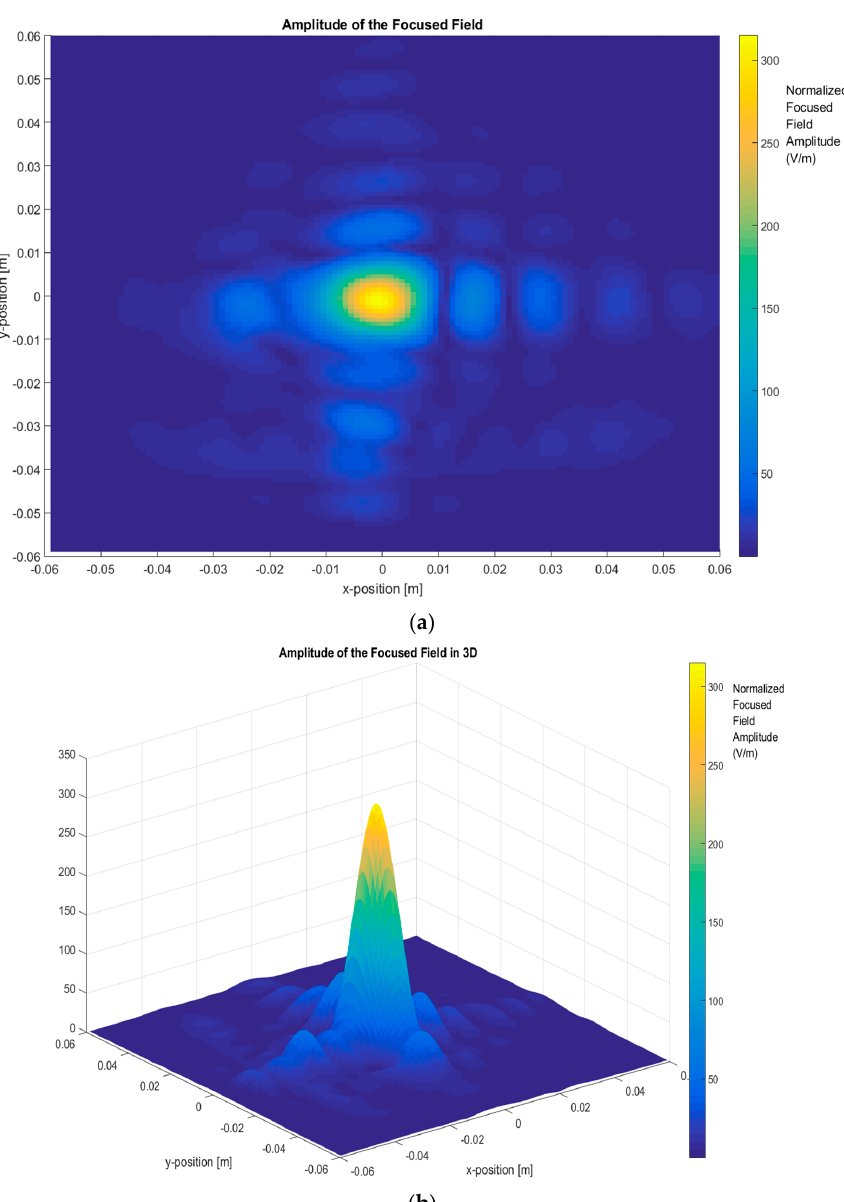
Figure 5. The focused field amplitude of a metallic car without an antenna. Frequency range: 220 GHz–330 GHz (BW = 110 GHz): ( a ) XY plane representation; ( b ) 3D representation of the focused field.